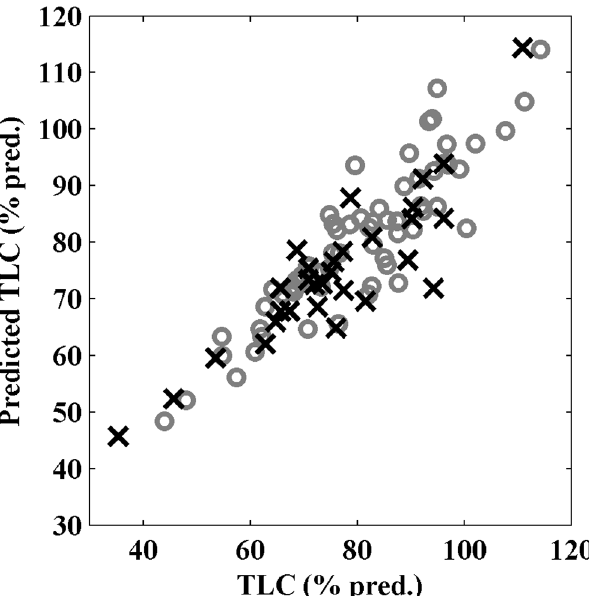
Fig 3. Multiple linear regression model for predicting total lung capacity (TLC) with the significant contributors forced inspiratory volume in 1 second (FIV1) and body mass index (BMI). Patients in the model and validation set are represented by gray circles and black crosses, respectively. The x-axis denotes the TLC expressed as percentage of the predicted value for each individual and the y-axis denotes the calculated predicted TLC (% pred.), based on FIV1 and